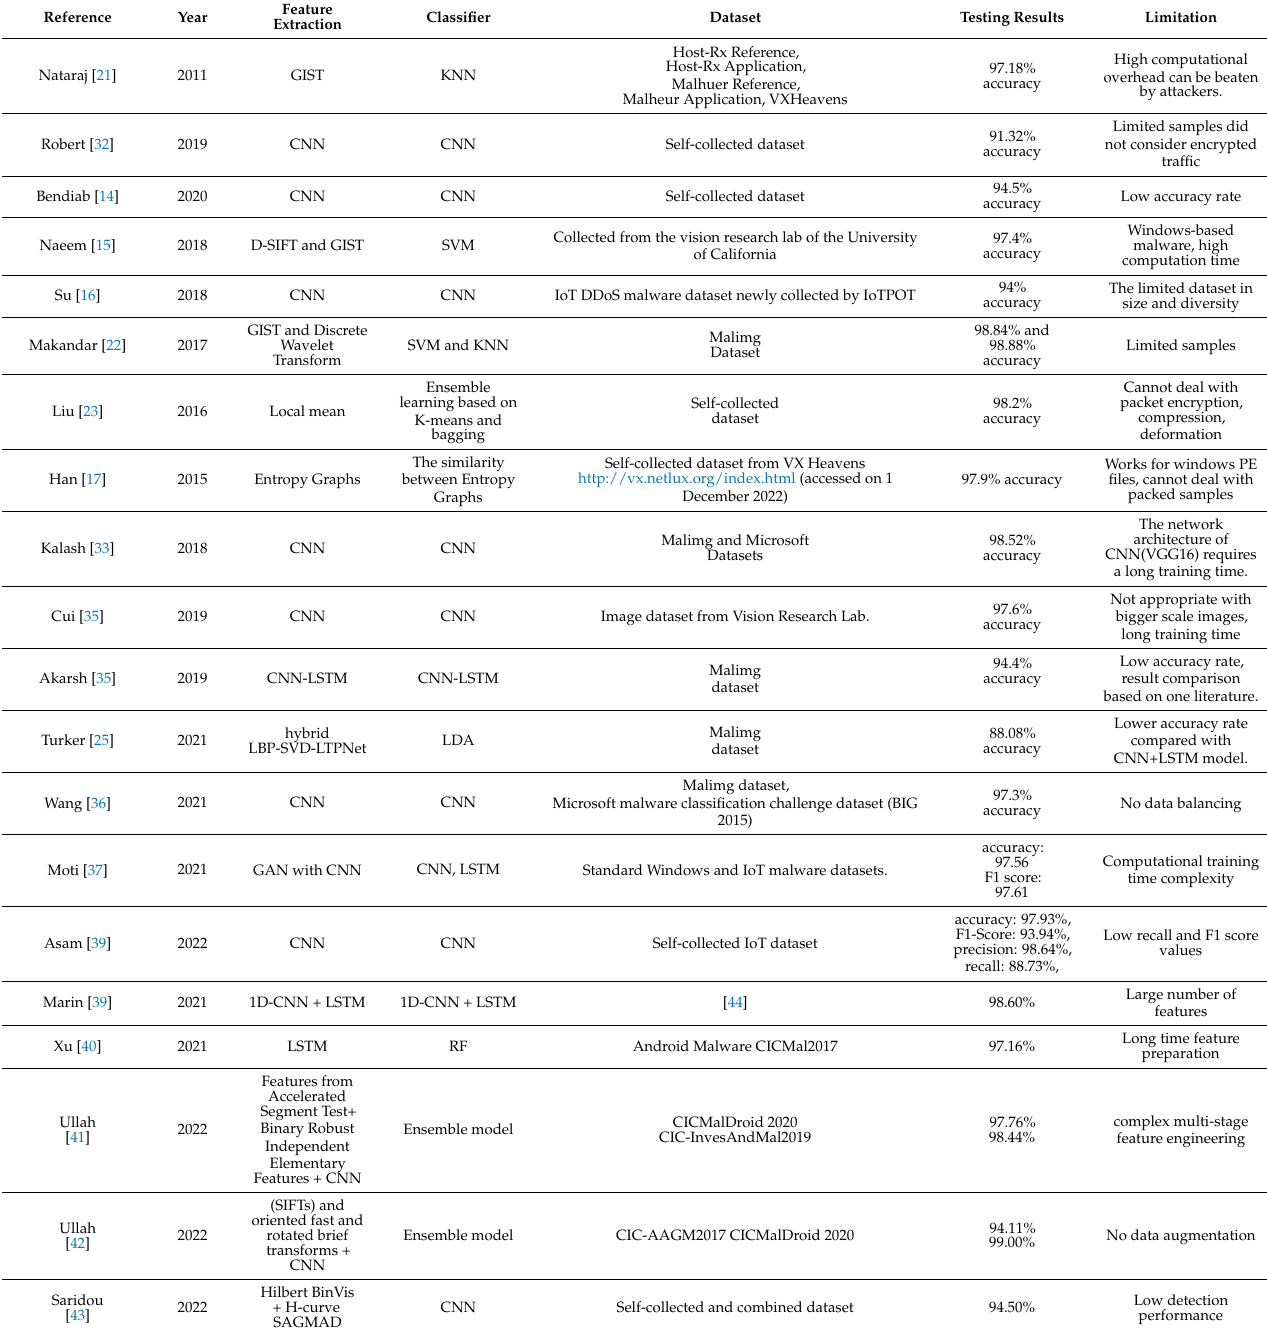
Table 1. Literature review